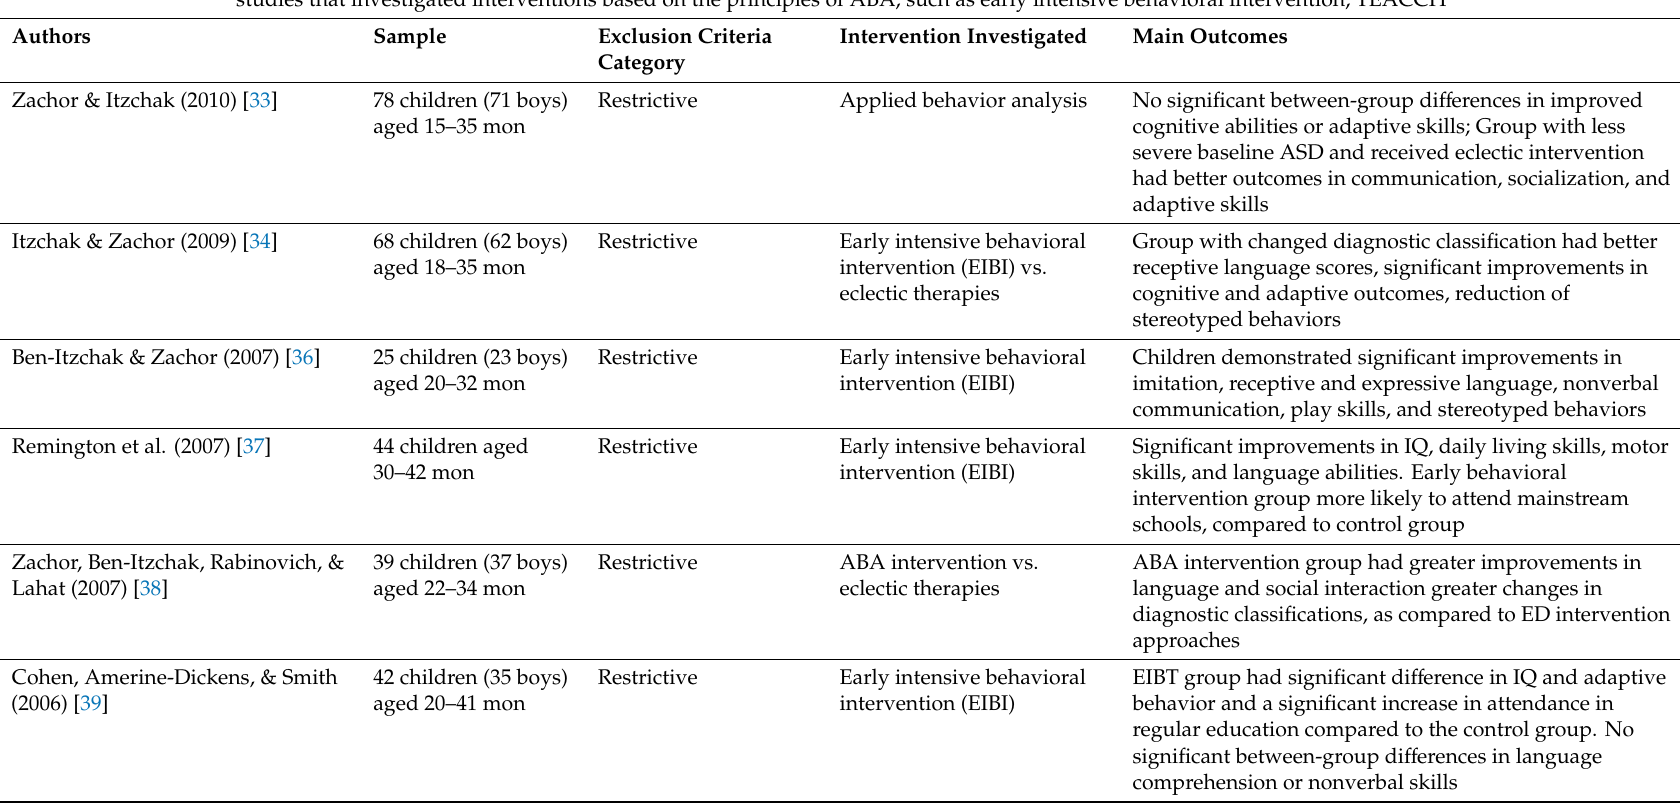
Table A2. Studies reviewed grouped by intervention